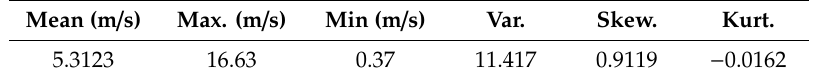
Table 11. The statistics information of supplementary case.